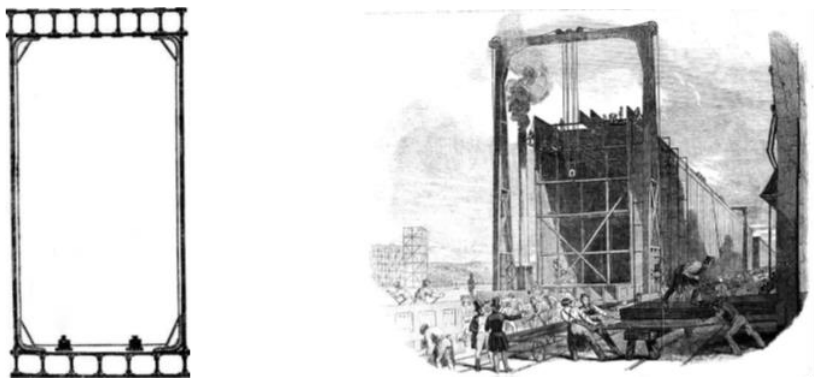
Figure 18. The bridge-tunnel or air tunnel over the Menai Strait. Detail of the screwed and gusseted drawer structure. Source: Engraving published by the magazine “ Revue Générale et des Travaux Publics ” , France, 1849. Vol.8, (Pl.22). Edited by César Daly. Reference [41].